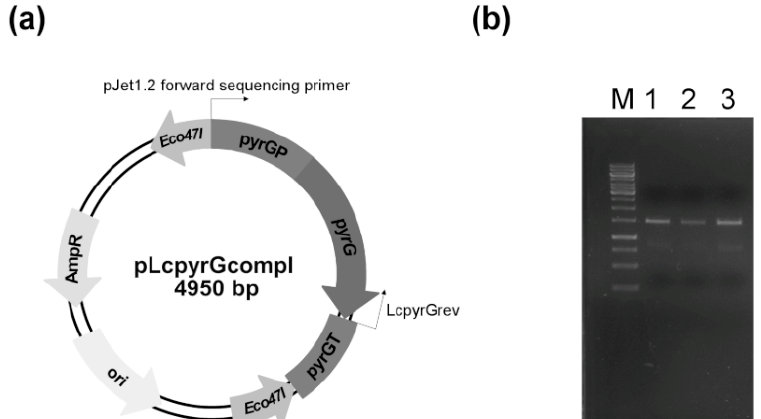
Figure 3. ( a ) Map of the plasmid used to complement the uracil auxotrophy of the CRISPR-Cas9-generated L. corymbifera mutants. Arrows indicate the recognition sites of the primers used to analyze the transformants. ( b ) An example of the PCR analysis of the complemented mutants. A fragment of the transferred plasmid was amplified from the pyrG -complemented CBS 429.75–pyrG cr1 / 1 strain using the primers pJet1.2 forward sequencing primer and LcpyrGrev. Lane M: GeneRuler 1 kb DNA Ladder (Thermo Scientific), Lane 1: CBS 429.75– pyrG compl / 1, Lane 2: CBS 429.75– pyrG compl / 2, Lane 3: CBS 429.75– pyrG compl / 3.